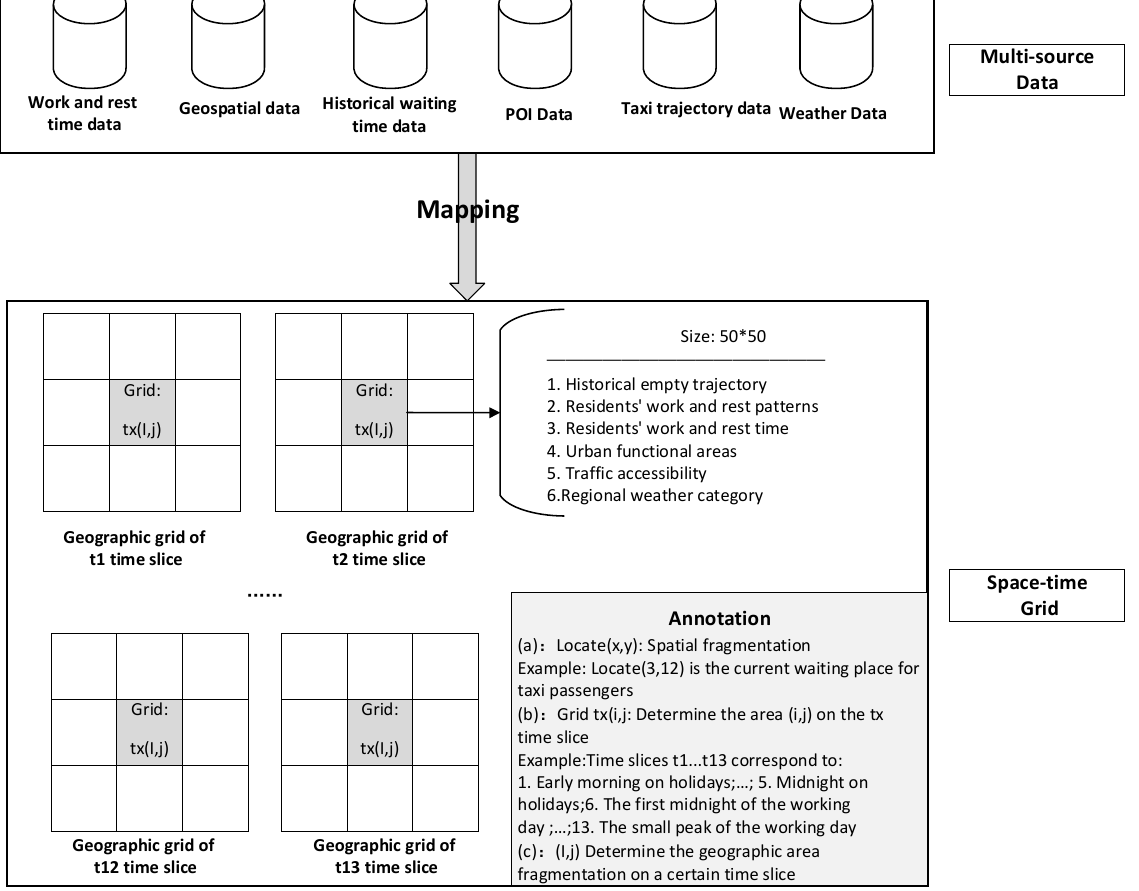
Figure 4. Multi-source data fusion Figure 4. Multi ‐ source data fusion method.